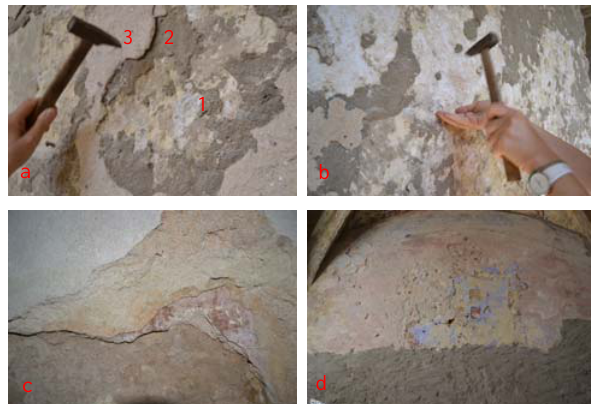
Figure 9: a) Sampling the different types of plaster found in the structure; three layers of plaster are recognizable (1 white, innermost, on wall; 2 dark gray, intermediate; 3 light gray, outer); b) detail of the oldest plaster layer; c-d) consecutive layers of plaster, up to 1 cm thick, placed on older layers, often still carrying the original paint